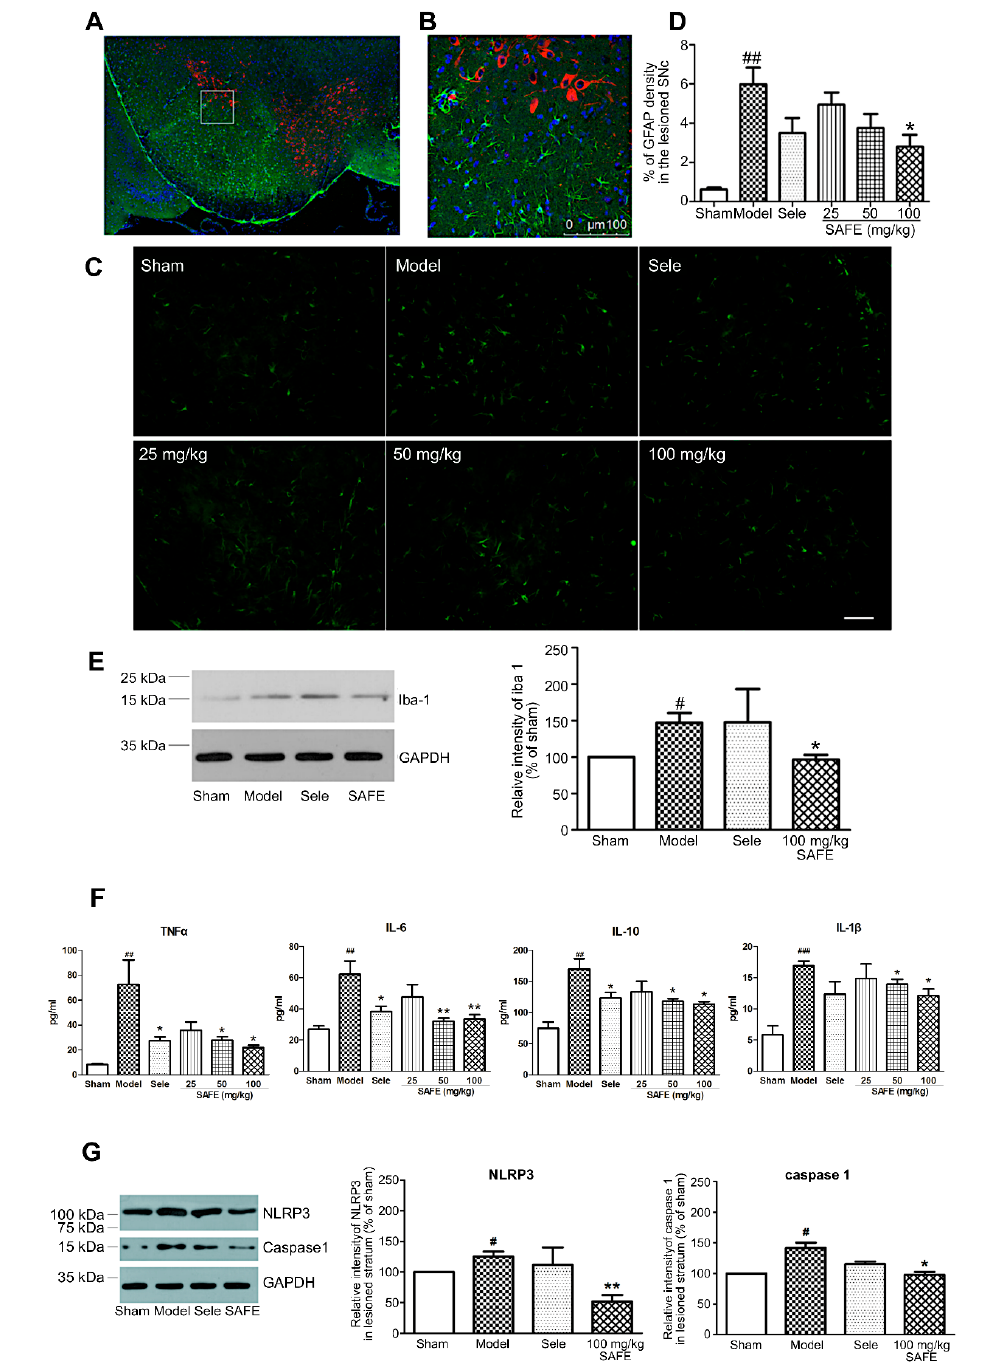
Figure 3. E ff ect of SAFE on inflammation. ( A ) Representative photographs of co-staining (model group, coronal section) of TH (red), glial fibrillary acidic protein (GFAP, green), and DAPI (blue) in the SN; ( B ) Enlarged views of the indicated regions in (A); ( C ) Representative images of GFAP-stained cells in the SN of mice in each group of animals (bar = 50 µ m); ( D ) Fluorescence intensity levels of GFAP-stained cells in the lesioned side of the SN in each group, n = 4; ( E ) Representative Western blot and quantitative analysis of the relative intensity of Iba-1 / GAPDH in the striatum, n = 3; ( F ) Plasma contents of TNF- α ( n = 7), IL-6 ( n = 8), IL-10 ( n = 5), and IL-1 β ( n = 4). Cytokine concentrations were determined using ELISA kits; ( G ) Representative Western blot images and quantitative analysis of the relative intensity of NLRP3 / GAPDH and caspase 1 / GAPDH, n = 3. # p < 0.05, ## p < 0.01, ### p < 0.001 vs. sham group and * p < 0.05, ** p < 0.01 vs. model